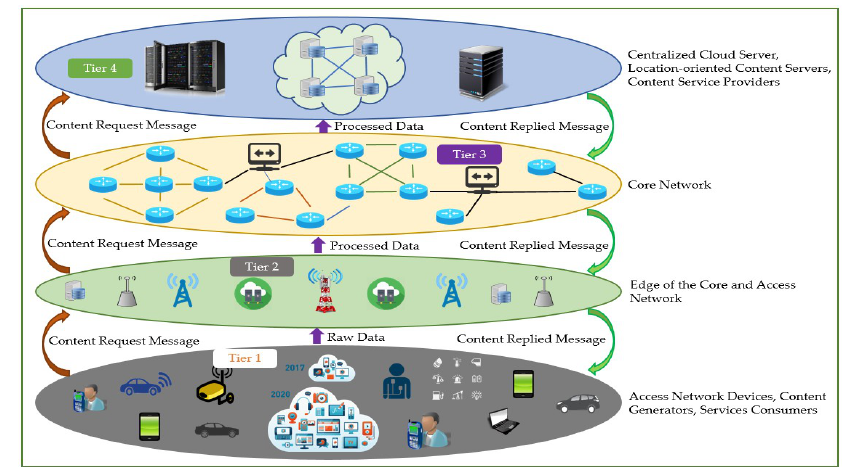
Figure 4. Content flow based on a tier architecture.